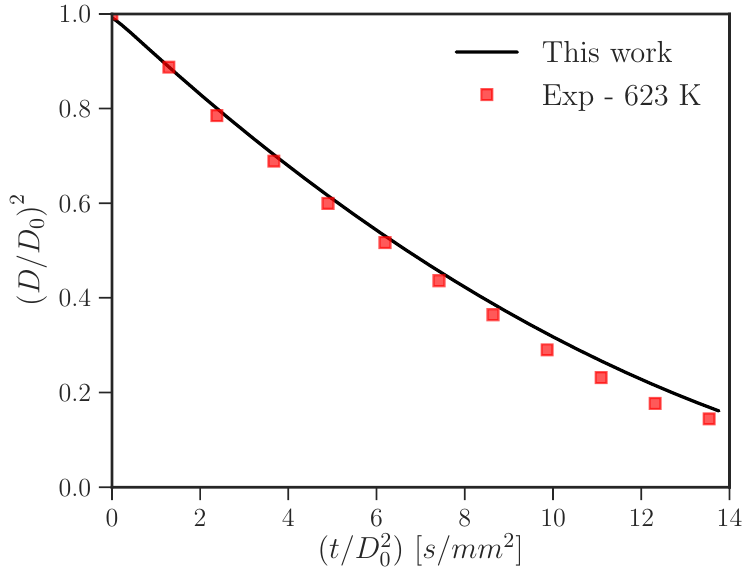
Figure 4. Normalized diameter squared against normalized time, lines represent simulation results and symbols represent experimental results from [32].